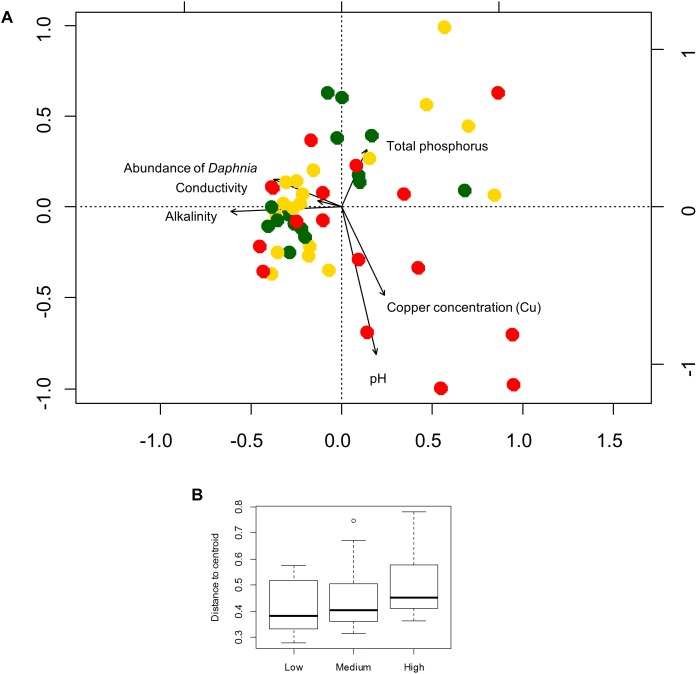
(A) Redundancy analysis of the bacterioplankton community composition for the abundant fraction (100 OTUs) and environmental variables selected by forward selection. Colors represent levels of urbanization around the ponds (low, medium, and high level) at subplot level. (B) Box-plot showing the variation (in terms of beta diversity) within bacterioplankton communities among the urbanization categories at subplot level. The average distance of a sample to the centroid of each urbanization category was used to calculate an F-statistic followed by a PERMUTEST.